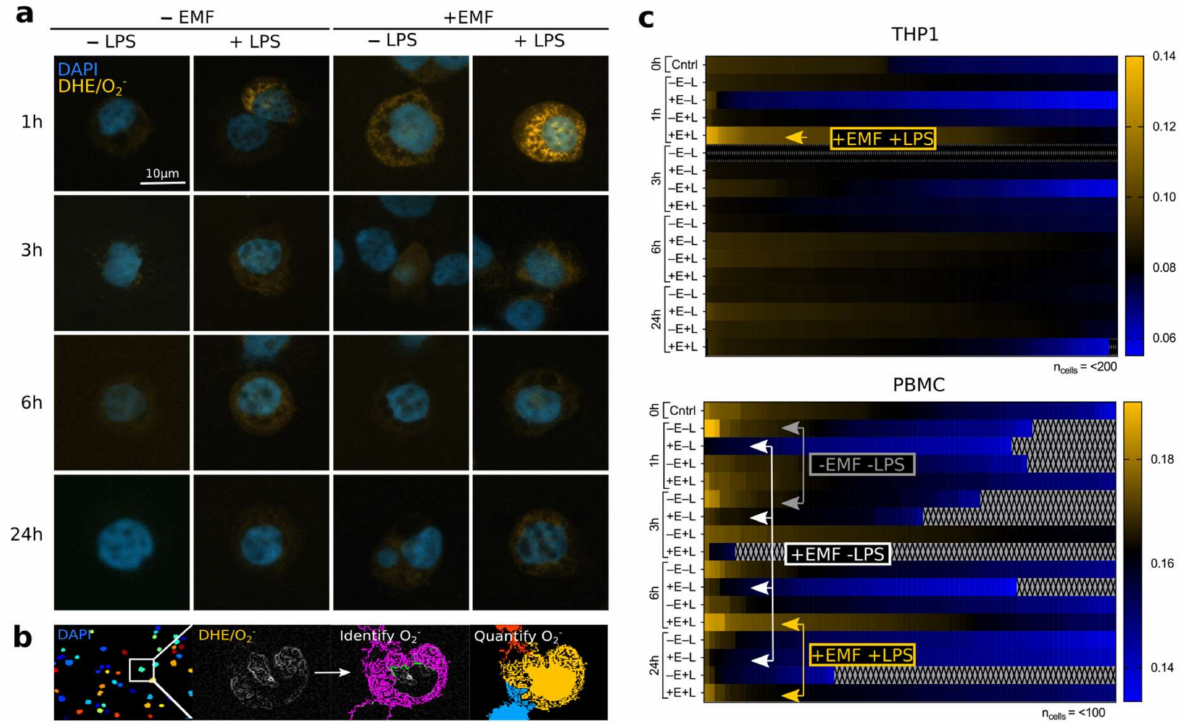
Figure 2. stEMF-modifies O 2 − levels in THP1 and PBMC. THP1 and PBMC with and without LPS stimulation were exposed to stEMF (<4.8 mT) for 1 h, 3 h, 6 h and 24 h, incubated with DHE for O 2 − detection and transferred to a slide by cytospin for DAPI staining and imaging. Representative single cell images of THP1 cells are shown in ( a ) for the tested exposure times and conditions. Fluorescence levels of DHE were detected and quantified using a specifically devised Cell Profiler pipeline shown in ( b ). ( c ) Increased O 2 − levels in LPS stimulated and EMF exposed samples are indicated in yellow (THP1 and PBMC). In PBMC, EMF exposure without LPS stimulation seemed to mitigate O 2 − formation (white arrows); basal levels at 1 h and 3 h are highlighted in gray. N = 200 (THP1) or n = 50–100 (PBMC) single cells were analyzed per individual